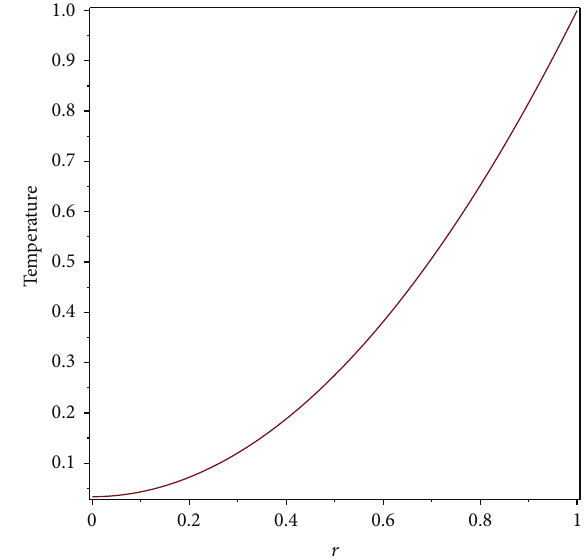
Figure6:Temperatureprofilegivensolutions(17)forvaryingvalues of 𝑛 . Here 𝑀 = 2 is fixed.